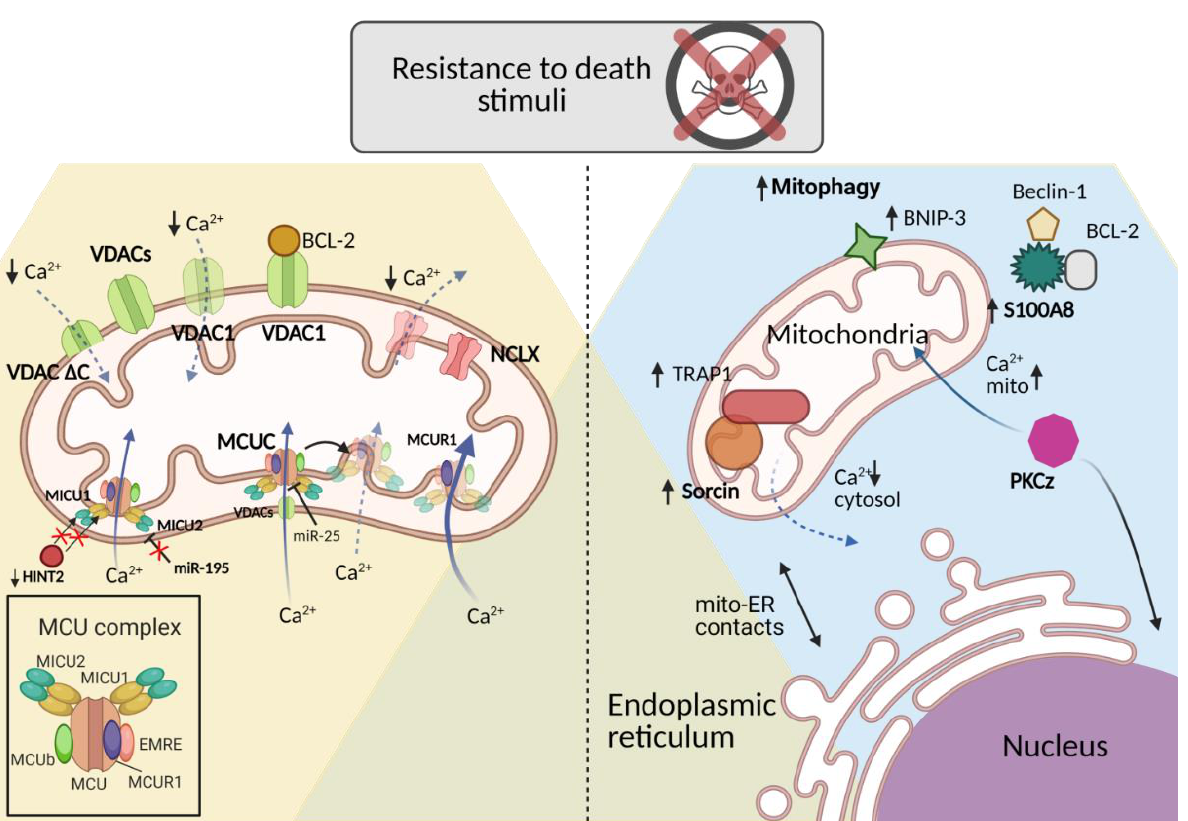
Figure 2. Mitochondrial Ca 2+ related proteins in chemoresistance regulation. Mitochondrial-resident proteins and cytosolic mitochondrial-related proteins are able to regulate mitochondrial Ca 2+ homeostasis affecting the sensitivity towards chemotherapeutic treatments. The mechanisms of regulation of mitochondrial Ca 2+ homeostasis in relation to different cancer types and treatments are detailed in the paragraph. (Created with Biorender.com, accessed on 18 March 2021).